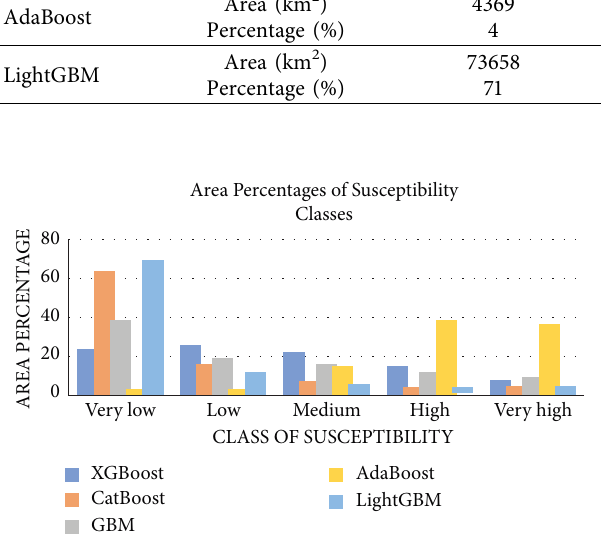
Figure 8: Area percentages of susceptibility